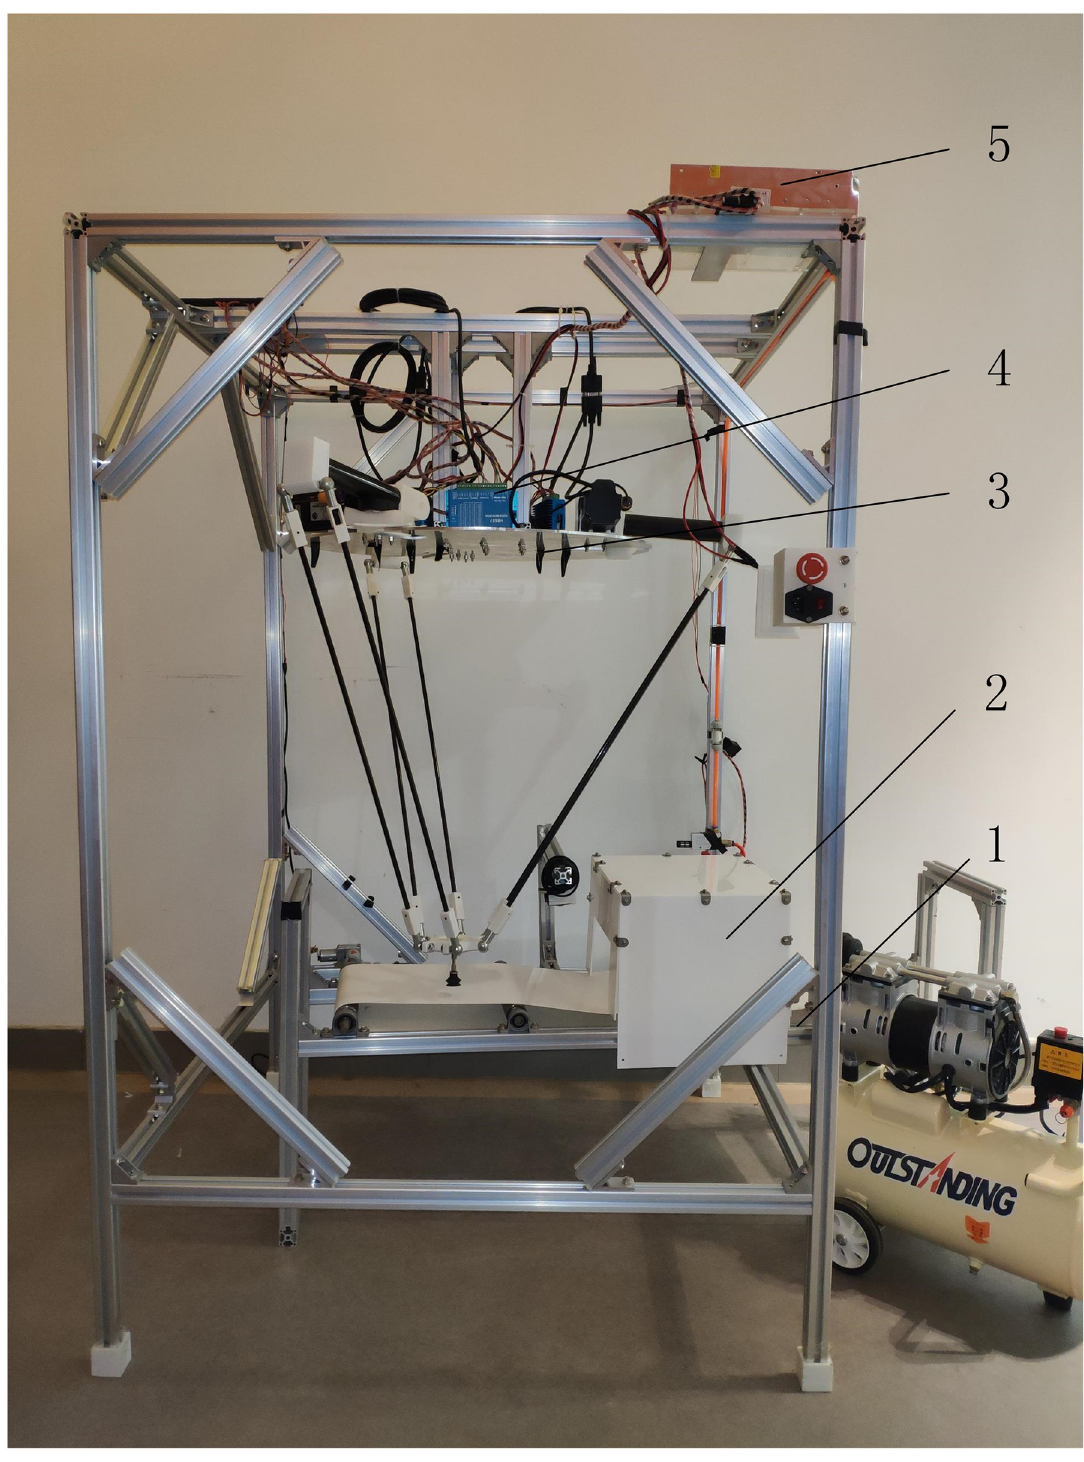
Fig 7. Automated tomato grading system. (1. Conveying mechanism; 2. Visual inspection box; 3. Grading execution mechanism; 4. PLC controller; 5. Microcomputer).